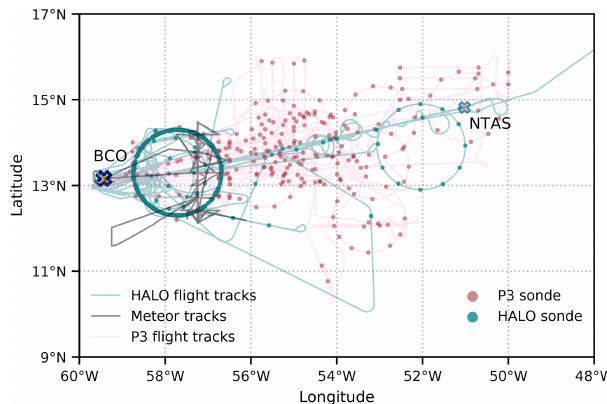
Figure 1. Map showing the launch locations of the dropsondes dur- ing EUREC 4 A from HALO (teal) and P3 (red). The flight paths for HALO (light teal), P3 (light pink) and Meteor (gray) are shown as shaded lines. The crosses near the west and east edges of the dis- played domain mark the location of the BCO and the NTAS buoy,